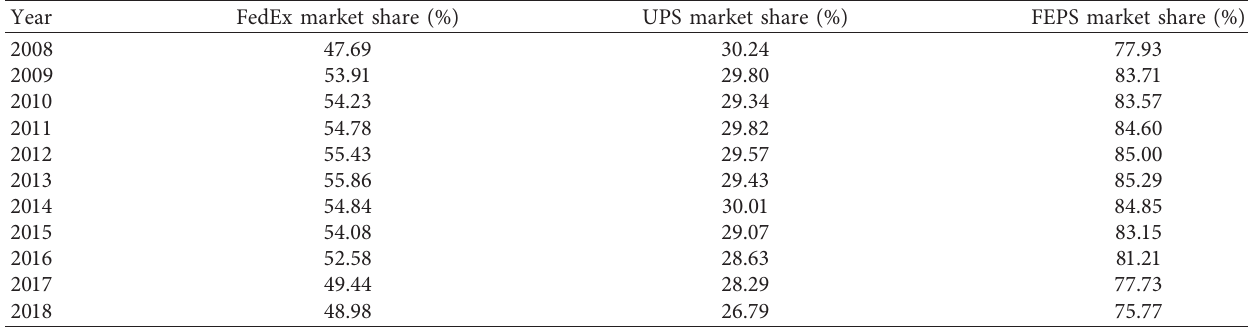
Table 1: FEPS domestic market share